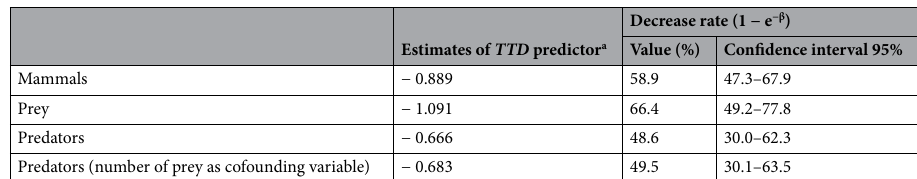
Table 2. Decrease in individual number by animal categories with an increase by a factor 10 in the generation time dose. a log 10 transformed but not scaled (i.e. not centered and not reduced), TTD in Gy before log